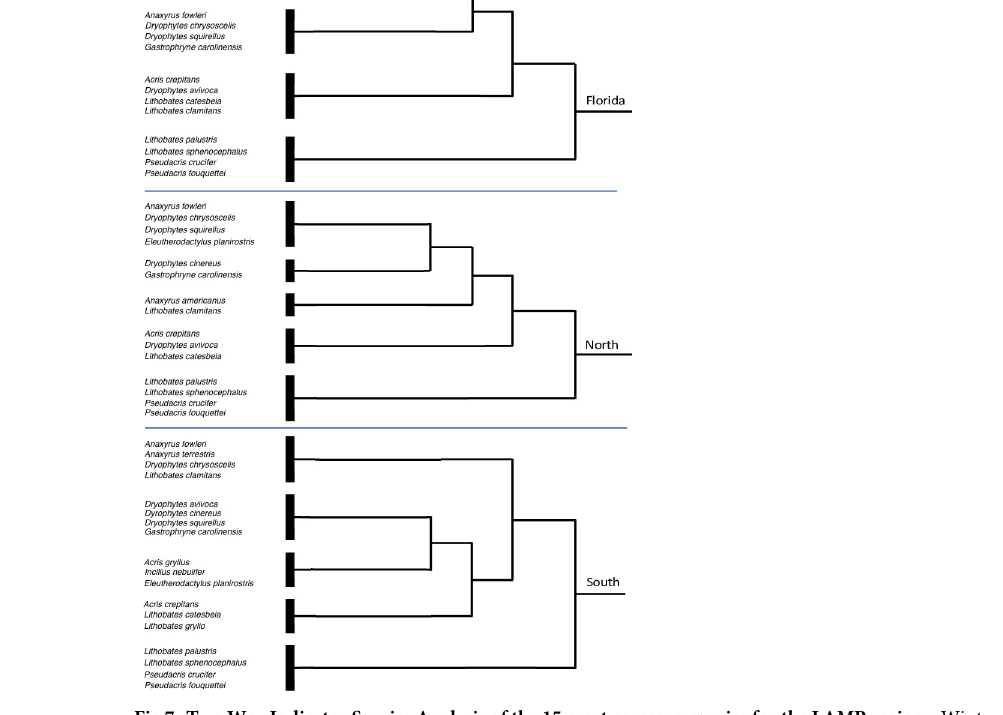
Fig 7. Two Way Indicator Species Analysis of the 15 most common species for the LAMP regions. Winter calling species ( L . palustris , P . crucifer , P . fouquettei , and L . sphenocephalus ) are the first species to cluster together. No other groupings were consistent across the